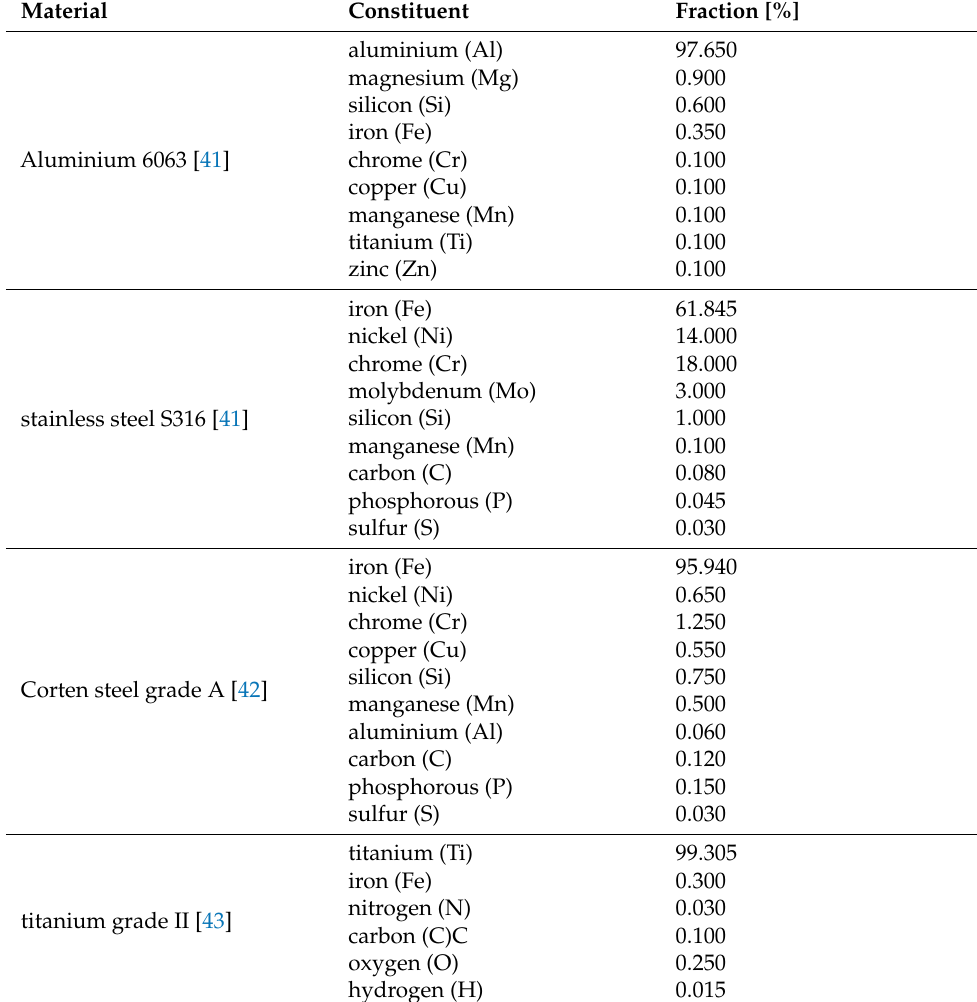
Table 2. The selected materials with their constituents were used for the sensitivity analysis.